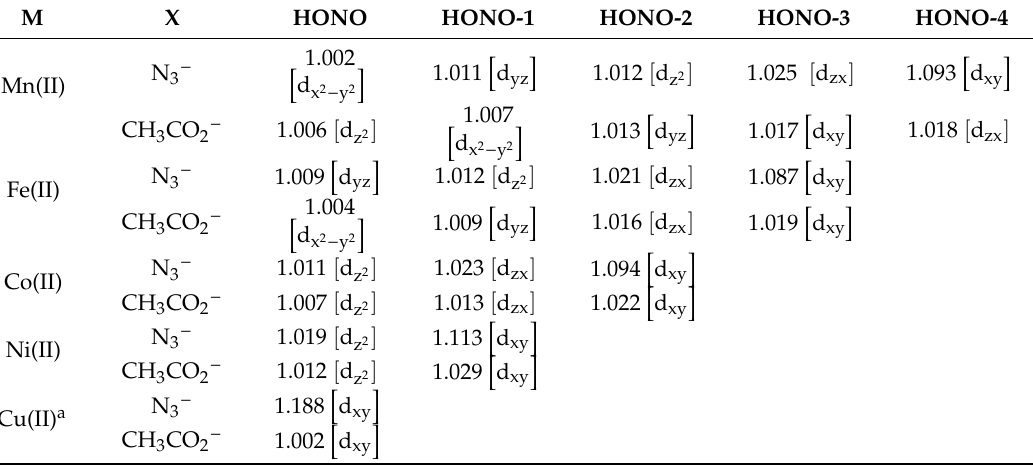
Table 3. Occupation numbers ( n ) of unrestricted natural orbitals (UNOs) for magnetic orbitals of model complexes, where dominant d-orbitals in each UNO are expressed in square